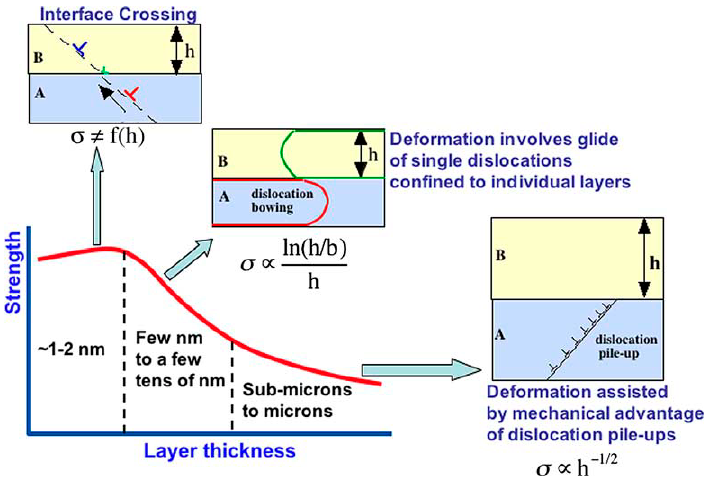
Figure 12. Deformation mechanisms active at different length scales [78]. Table 1. Peak hardness H max and hardness enhancement H max / H rom for a variety of Cu/X multilayers. Layer Thickness, Systems (Cu/X) h nm